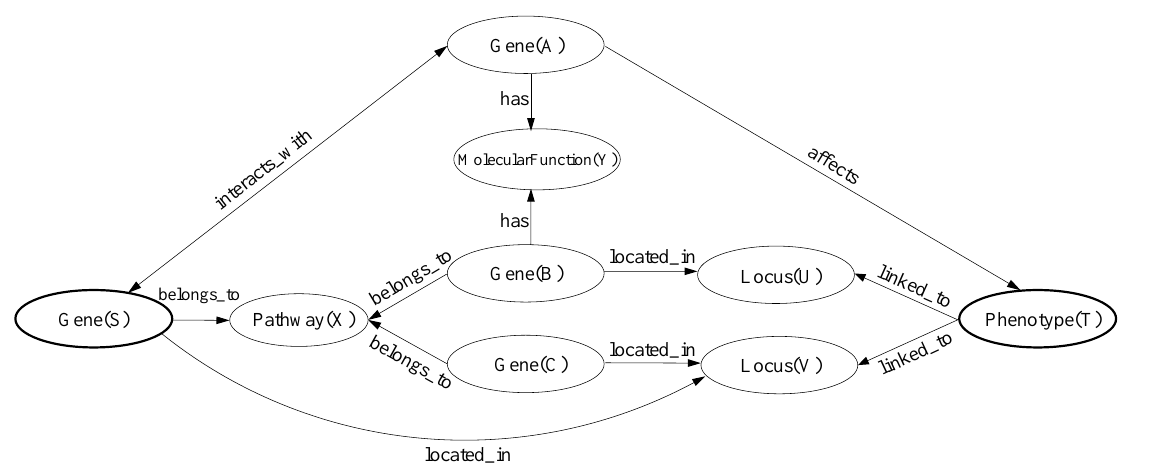
Figure 1: A fictional example connection subgraph summarizing the link between a gene and a phenotype. The user has specified the source and target vertices (Gene(S) and Phenotype(T)), and the class of path types of interest (path types suggesting causal